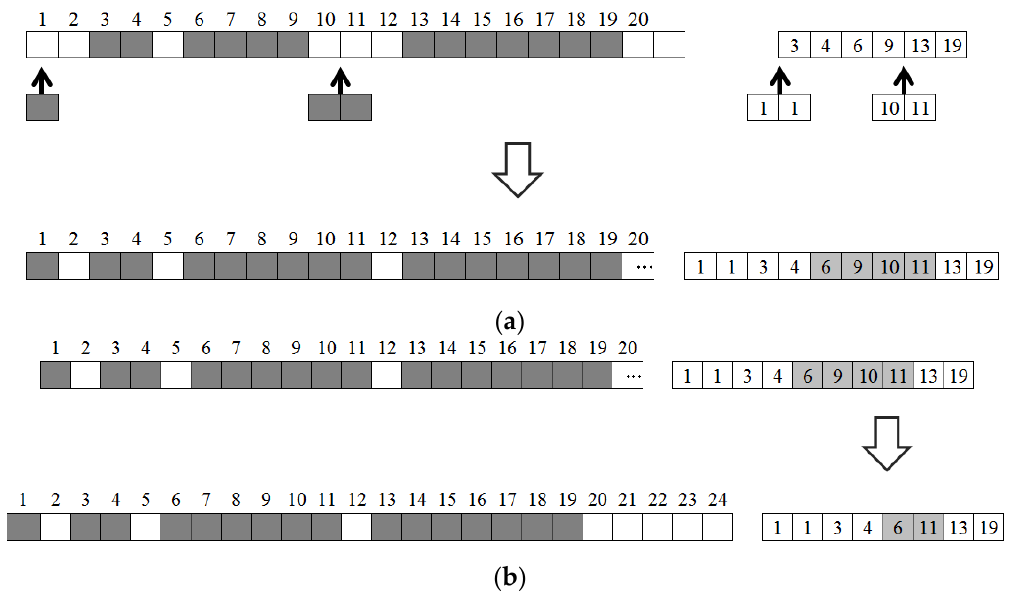
Figure 3. ( a ) Insertion of two on-periods and resulting proto-offspring; and ( b ) trimming redundant slot.